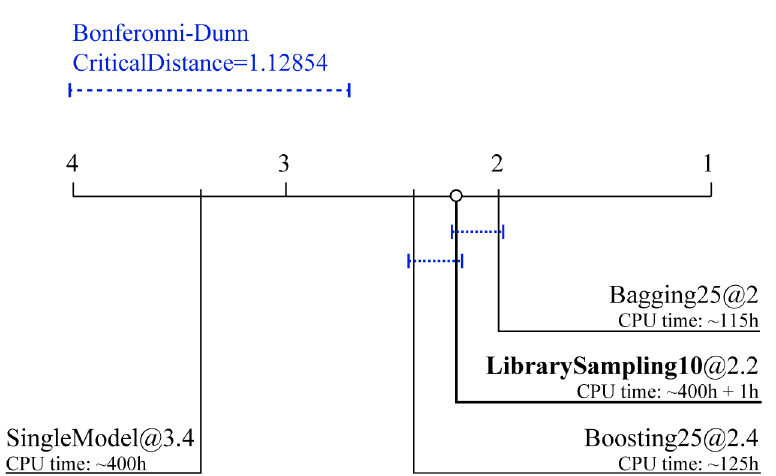
Fig 7. Comparison of the average ranks for predictive performance of the library sampling method to learning single models, bagging and boosting. Average ranks of the ensembles constructed by library sampling with 10 constituents combined by averaging to the performance of: a single model and two types of ensembles combined by averaging constructed by bagging and boosting (with 25 constituents). The ranks of the models in terms of their predictive performance and the average CPU times for learning them are averaged over the 15 data